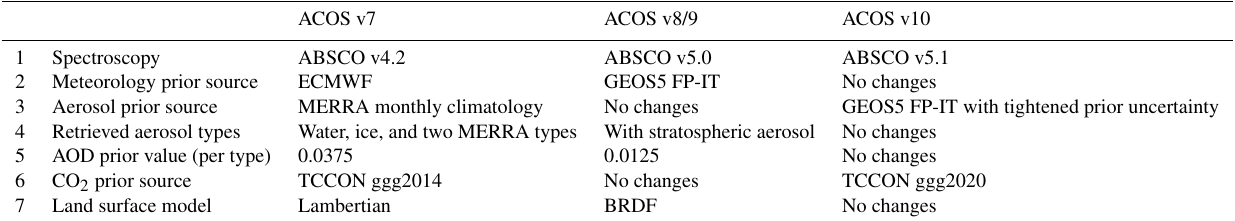
Table 1. Evolution of the Atmospheric Carbon Observations from Space (ACOS) Level 2 Full Physics (L2FP) retrieval algorithm (Taylor et al.,